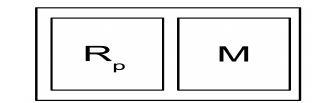
Figure 3. A context-aware action system for the basic version.